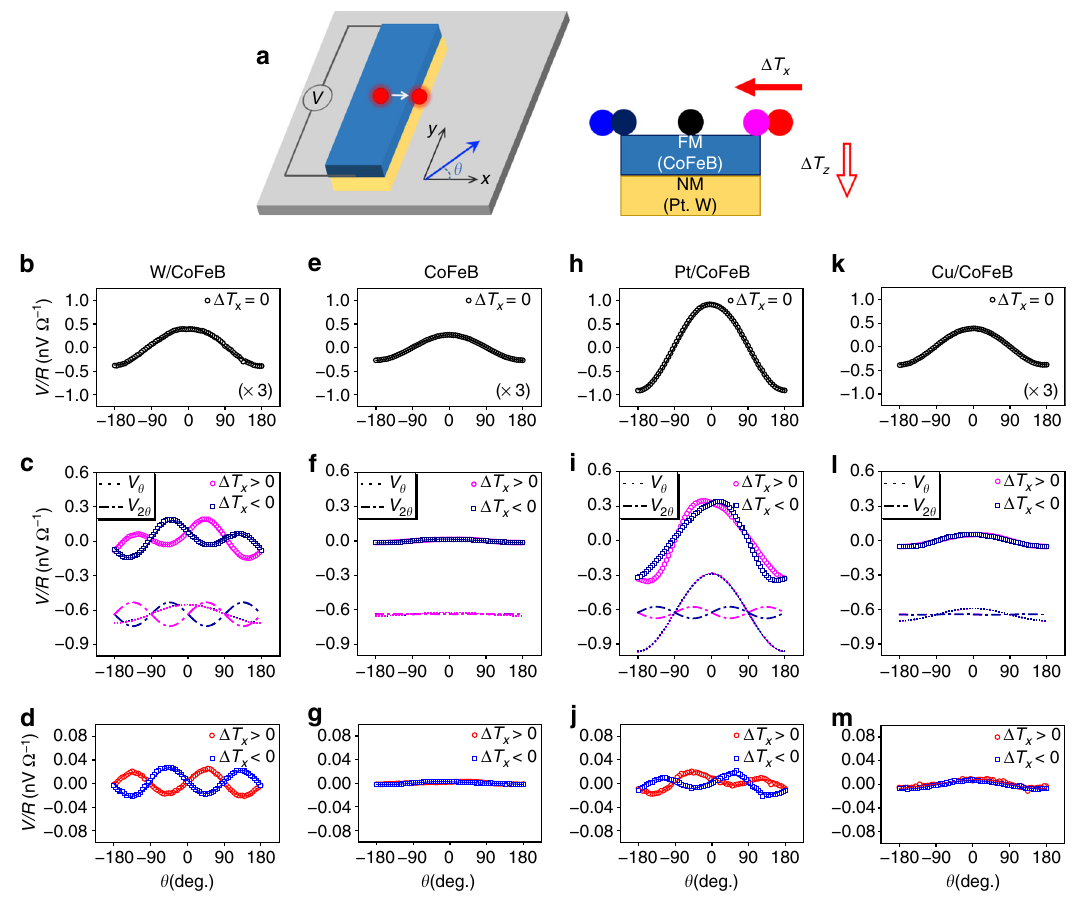
Fig. 2 Transverse spin Nernst magnetoresistance originating from SNE in various layer structures. a Schematics of measurement under different laser position on bar-shaped structure. The x – z plane view indicates the laser positions along the x direction. Each color of circle represents the laser position. b – m Thermoelectric Hall signals for W(3 nm)/CoFeB(2 nm) ( b – d ), CoFeB(2nm) ( e – g ), Pt(3 nm)/CoFeB(2 nm) ( h – j ), and Cu(3 nm)/CoFeB (2 nm) structures ( k – m ) for different laser locations, at the center ( x ~ 0 μ m, b , e , h , k ), edge ( x ~ 5 μ m, c , f , i , l ), and outside of the structure ( x ~ 10 μ m, d , g , j , m ) for each sample, which are normalized by sample resistance. Dotted and dash-dotted lines ( c , f , i , l ) show the decomposition of two angle-dependent signals of cos θ and sin 2 θ . The symbol color denotes the laser position as illustrated in schematics of Fig. 2a